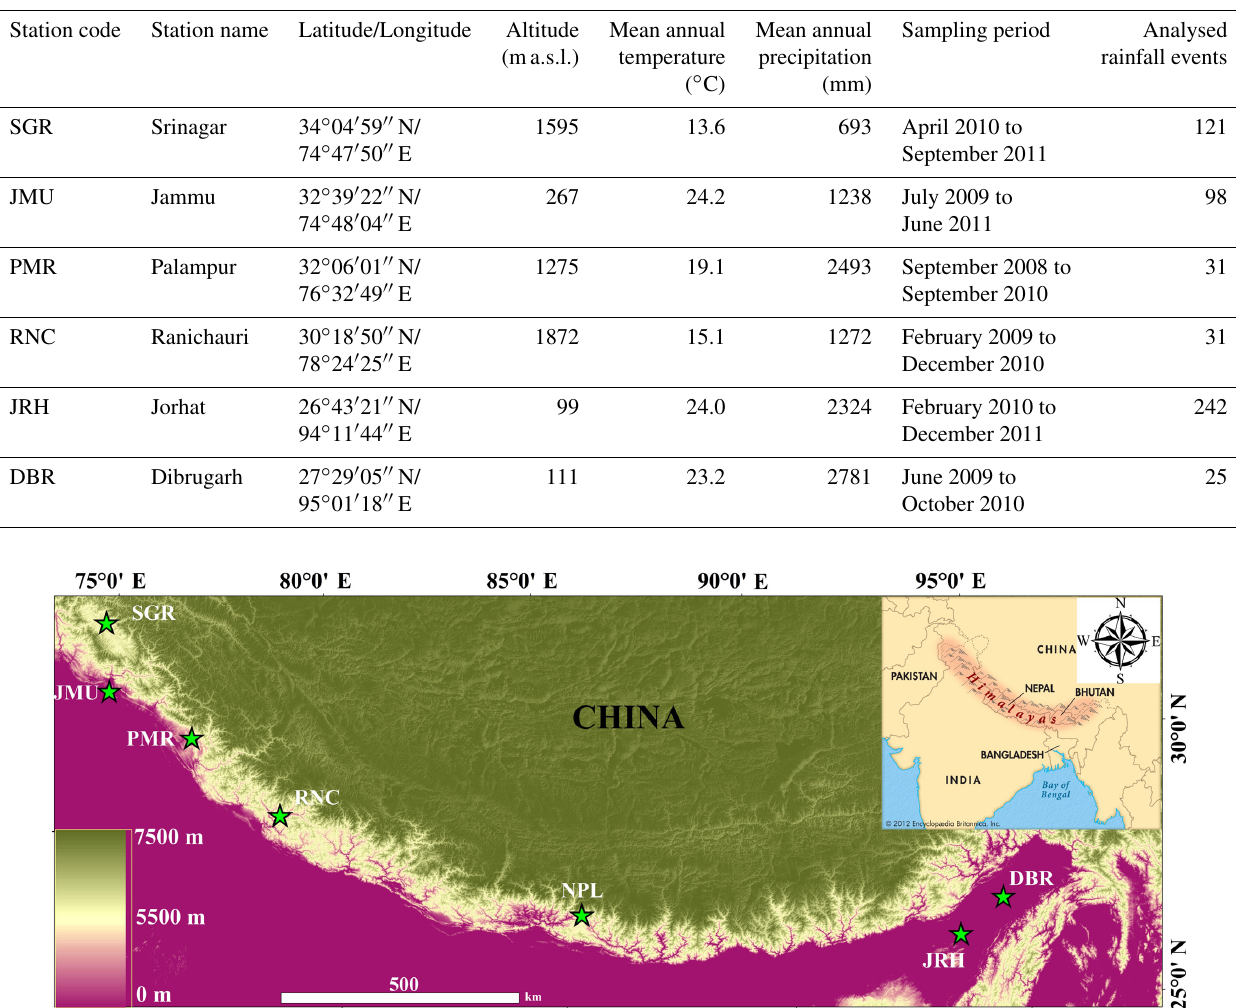
Table 1. General characteristics of the stations collecting daily precipitation samples for isotope analyses.